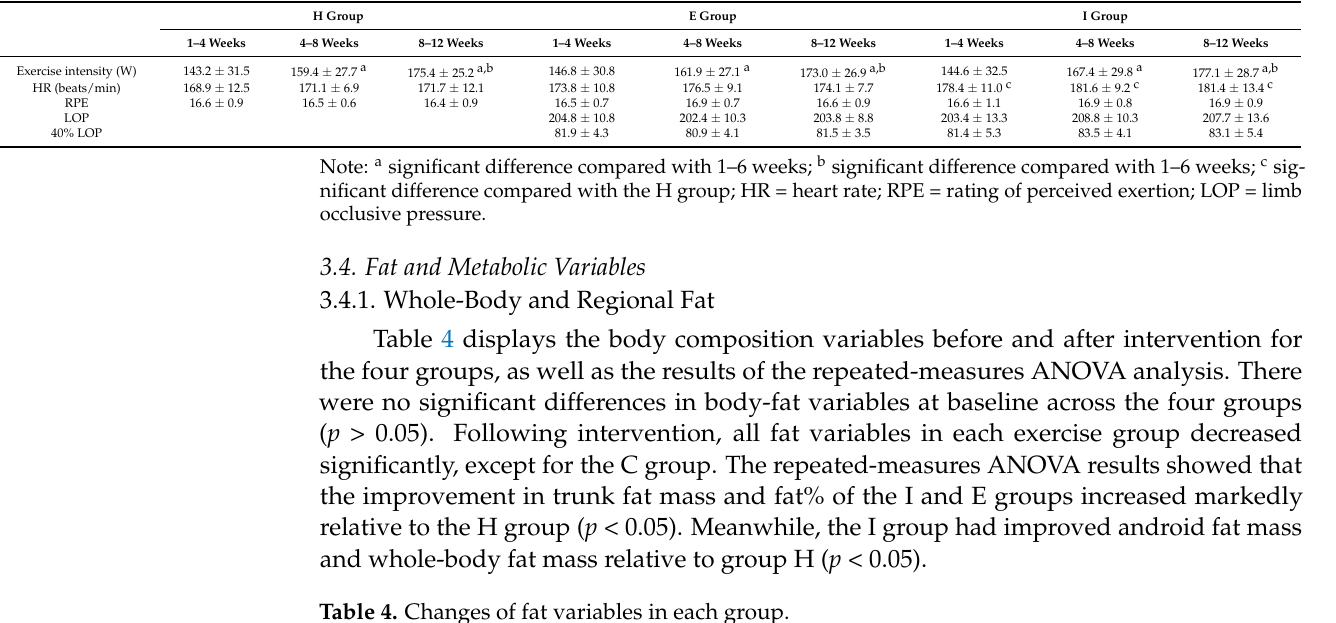
Table 3. Exercise intensity, HR, RPE, and LOP of each group.